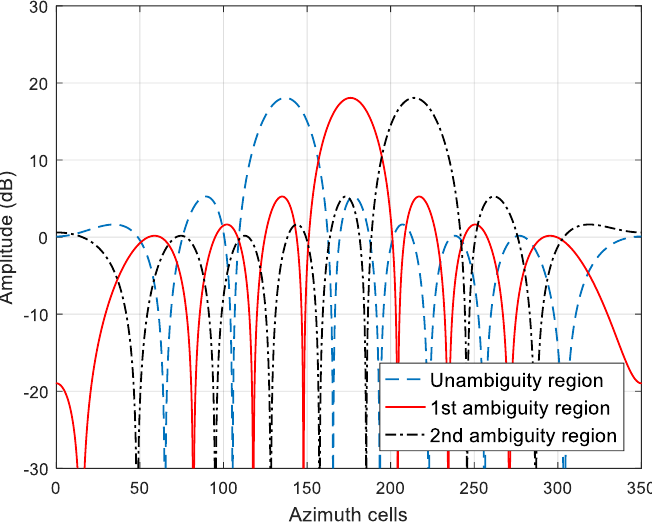
Figure 9. Designed passband time filter.